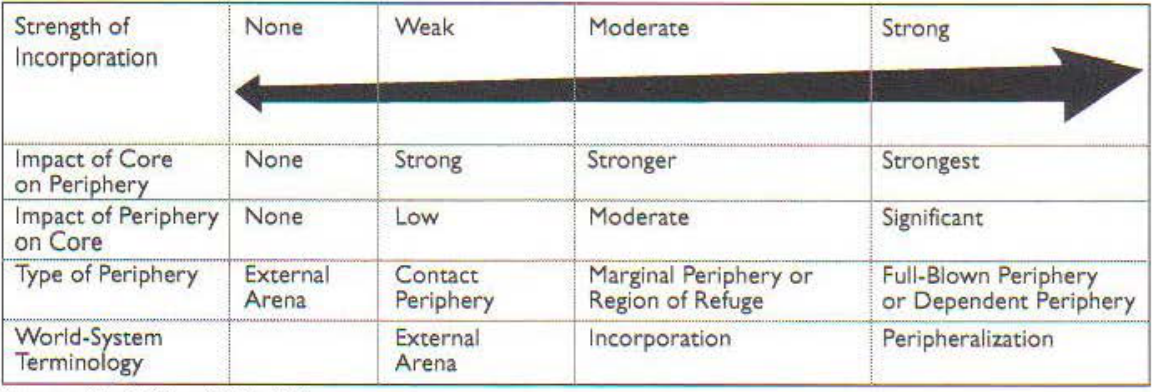
Figure 1: The Continuum